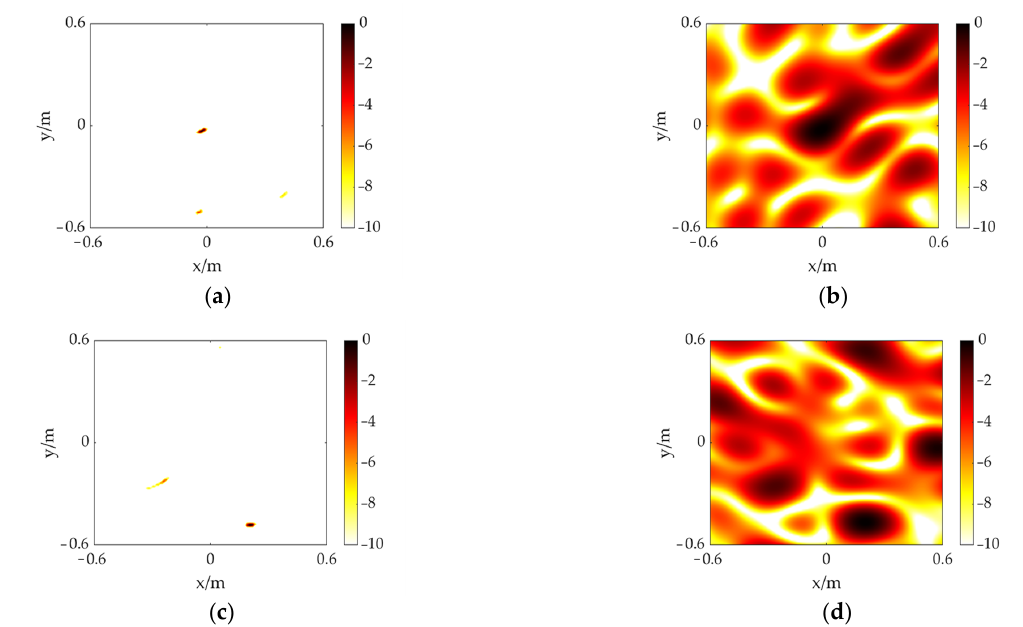
Figure 11. The experiment results of a PD source at different positions. ( a ) FFT ‐ FISTA, (0, 0); ( b ) CSIF, (0, 0); ( c ) FFT ‐ FISTA, (0.20, − 0.45); ( d ) CSIF, (0.20, − 0.45).